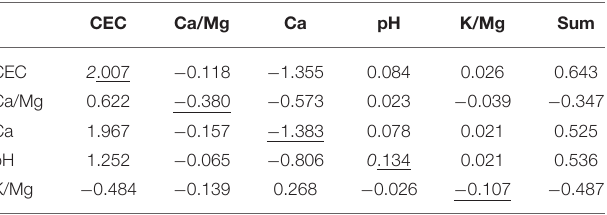
The underlined data are direct path coefficients and the rest are indirect path coefficients, and the sum represents the sum of the direct and indirect path coefficients for each property.